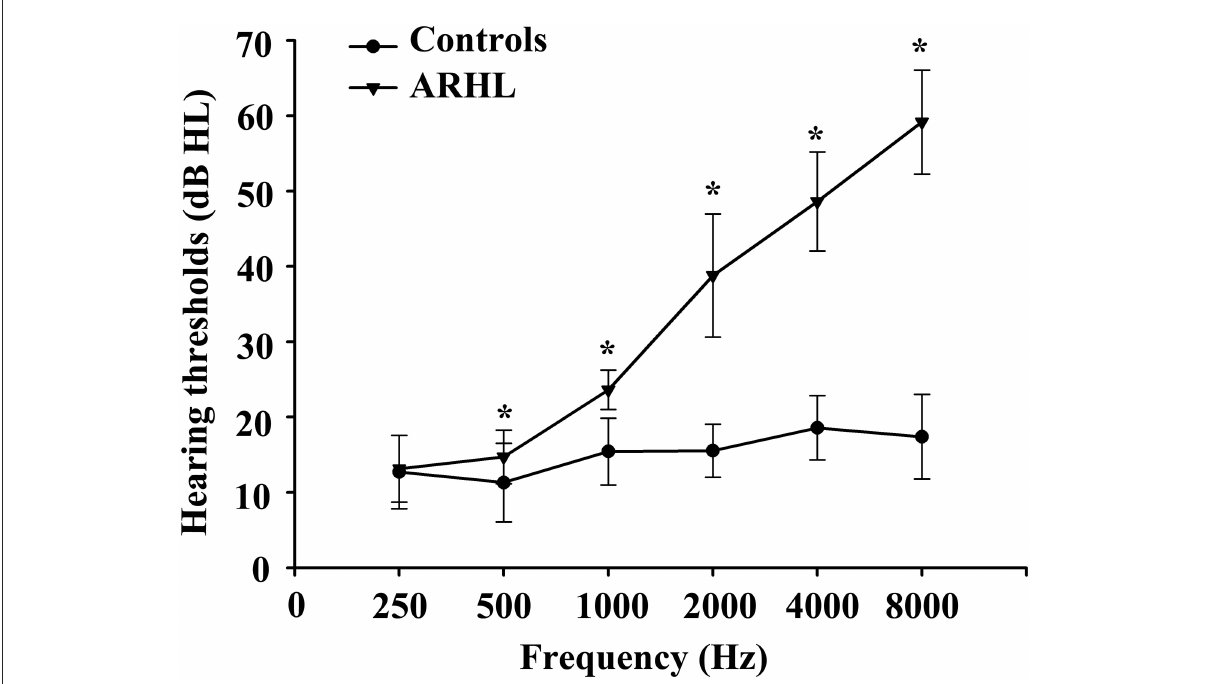
FIGURE1 Hearing thresholds of ARHL and healthy controls using PTA test. Data are shown as mean ± SD. PTA, pure-tone audiometry. * Means significant differences of hearing thresholds between two